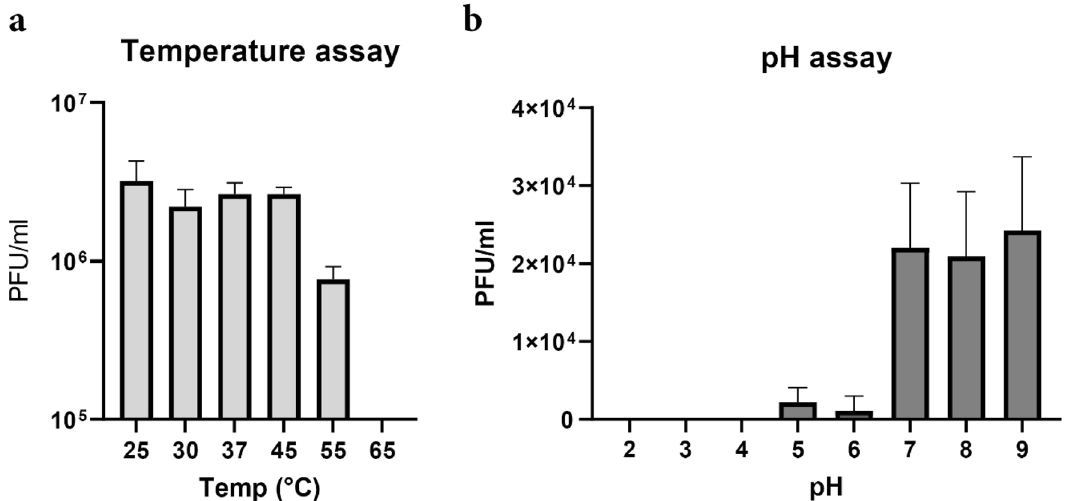
Figure 5. Stability of phage Pablito. ( a ) Phage Pablito remains relatively stable at temperatures ranging from 25 to 45 °C, but decreased stability is observed at higher temperatures. ( b ) Phage stability was optimal at pH of 7.0 and higher. A significant drop in PFU’s was observed at pH ≤